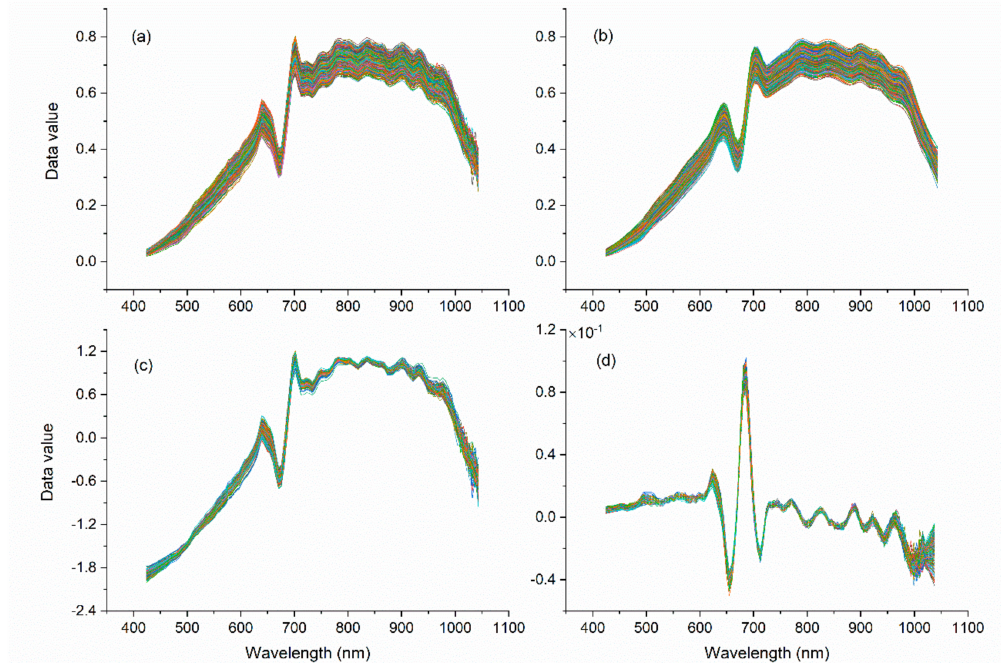
Figure 3. Pretreatment spectrum curves. ( a ) original spectrum (OS) curve; ( b ) Savitzky-Golay (SG); ( c ) standard normal variate (SNV); and ( d ) first derivative (FD).